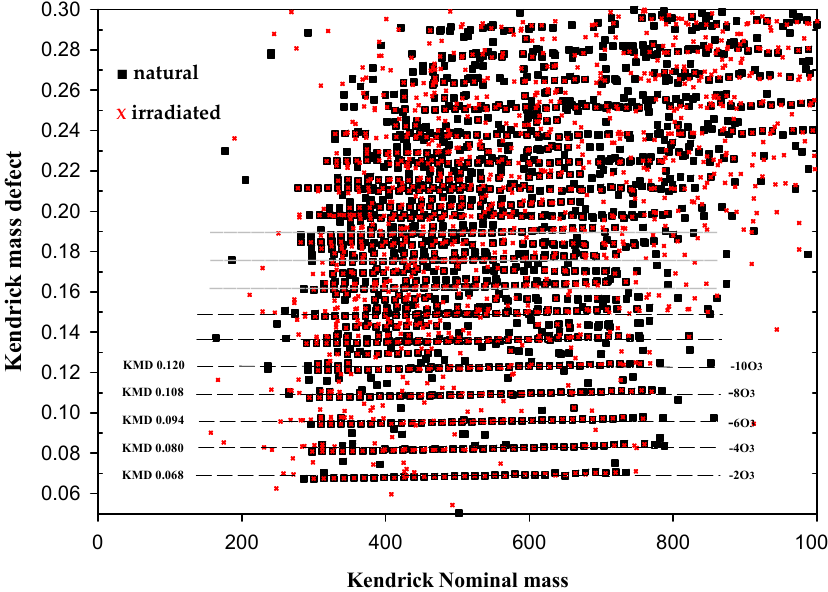
Figure 2. Kendrick mass plot of the O 3 species found in natural ( ■ ) and irradiated oil ( X ). This plot illustrates the increase in the number of rings plus double bonds as the KMD increases ( y -axis) and the alkylation series along the x -axis. Table 1. Homologous series of O 3 class with <Z> = − 20.